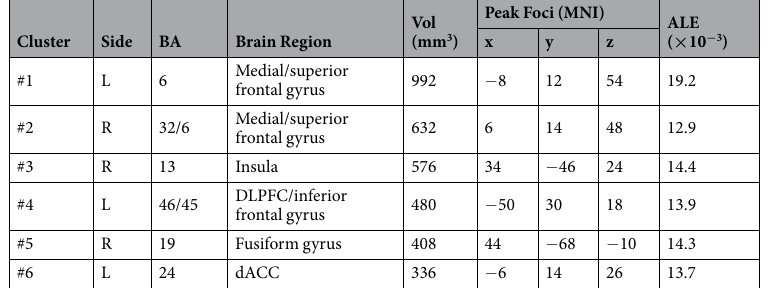
Table 1. Brain activation underlying emotional interference on cognitive control in 16 fMRI studies using an emotional Stroop task. DLPFC: dorsolateral prefrontal cortex; dACC: dorsal anterior cingulate cortex.